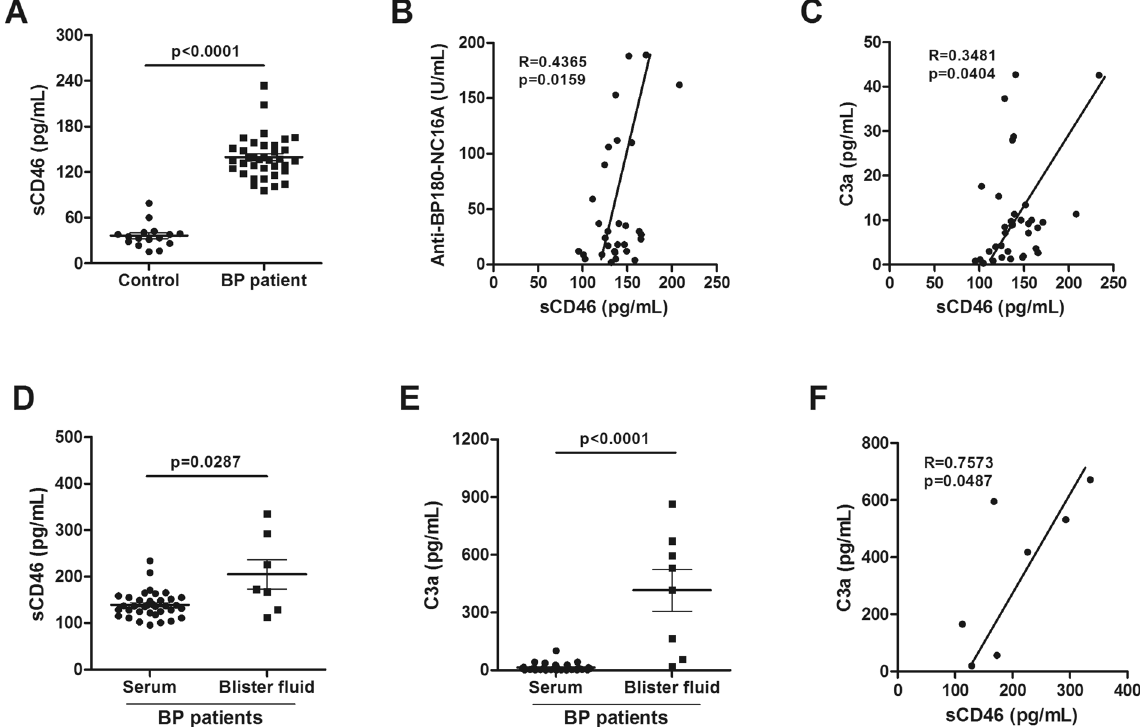
Figure 1. Up-regulation of sCD46 expression in serum and blisters of BP patients. ( A ) ELISA assay was used to determine the sCD46 level in serums from 36 BP patients and 16 healthy controls ( B , C ) Positive correlations for ELISA assay between the levels of ( B ) sCD46 and anti-BP180-NC16A titer and ( C ) sCD46 and C3a in serums of BP patients. ( D , E ) ELISA assay of protein levels of ( D ) sCD46 and ( E ) C3a in blister fluids from 7 BP patients. ( F ) Positive correlations for ELISA assay between the levels of sCD46 and C3a in blister fluids of BP patients. P < 0.05 was considered